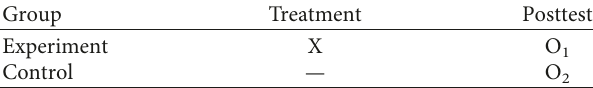
continuous distribution. This study did a homogeneity test Table 1: Model of posttest-only control design.